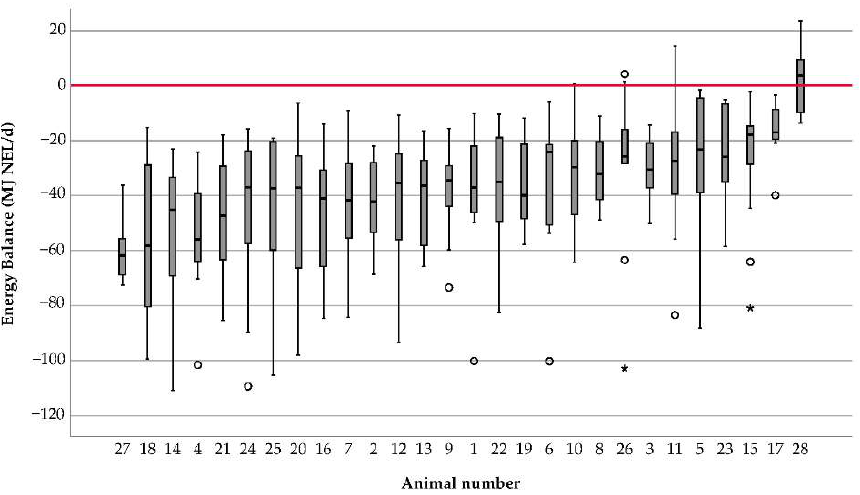
Figure 9. Energy balance (MJ NEL/d) calculated between weeks 2 and 15 postpartum (p.p.). In each subfigure, the boxplots respectively highlight the median, upper, and lower quartiles of each week. Box whiskers extended to the most extreme nonoutlier data points were considered as outliers if they lay more than 1.5 times the interquartile range from the edge of the box. Small circles = outliers (1.5 × interquartile range (IQR)); asterisks = extreme values (3 × IQR).